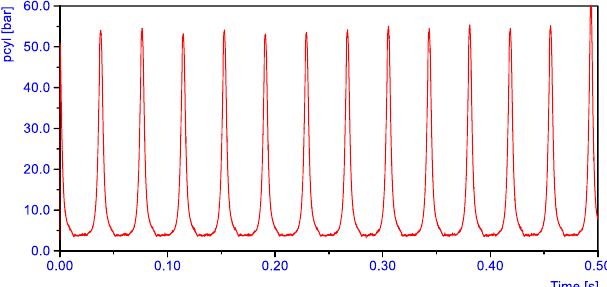
Fig. 7. Fragment of the pressure in the first cylinder – operating point No. 3